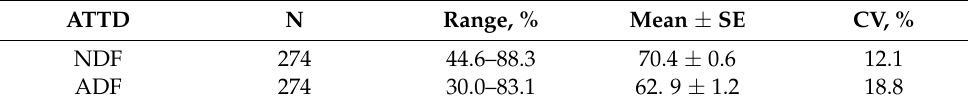
Table 1. Data regarding the ATTD of NDF and ADF. ATTD N Range, % Mean ± SE